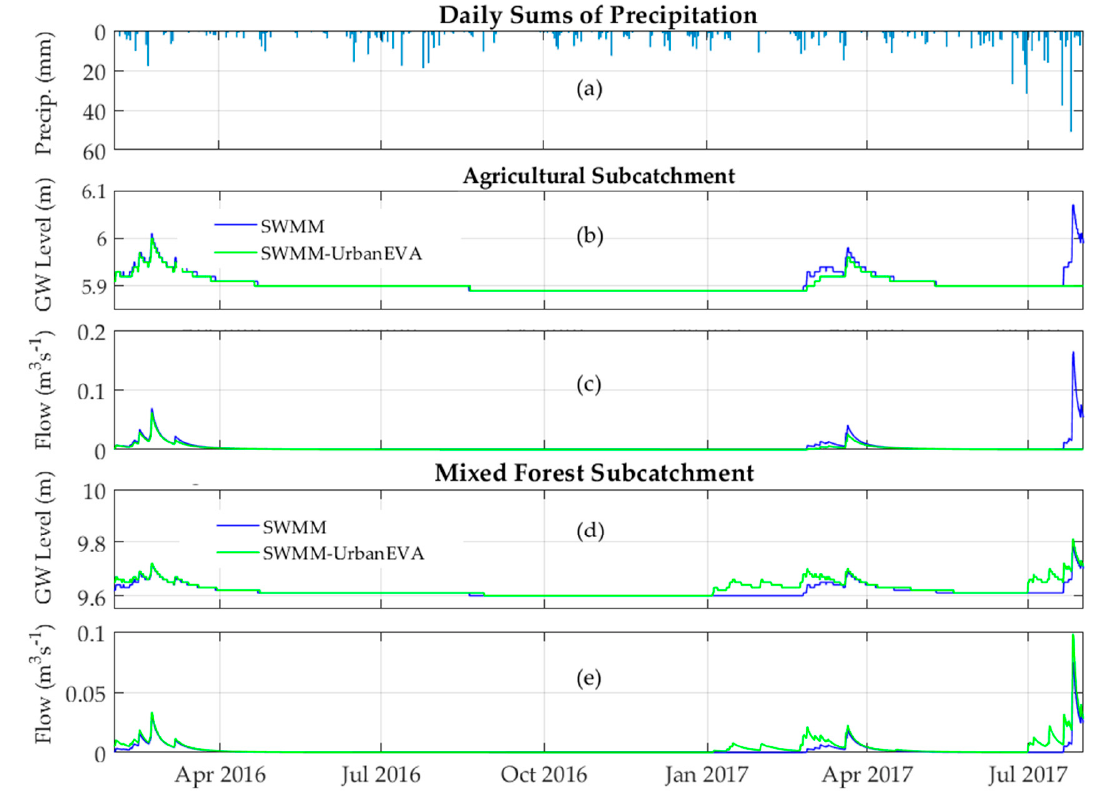
Figure 9. Daily sums of precipitation ( a ), GW flow and GW level for an agricultural subcatchment ( b ), ( c ) and for a mixed forest subcatchment ( d ), ( e ) simulated with SWMM and SWMM-UrbanEVA.